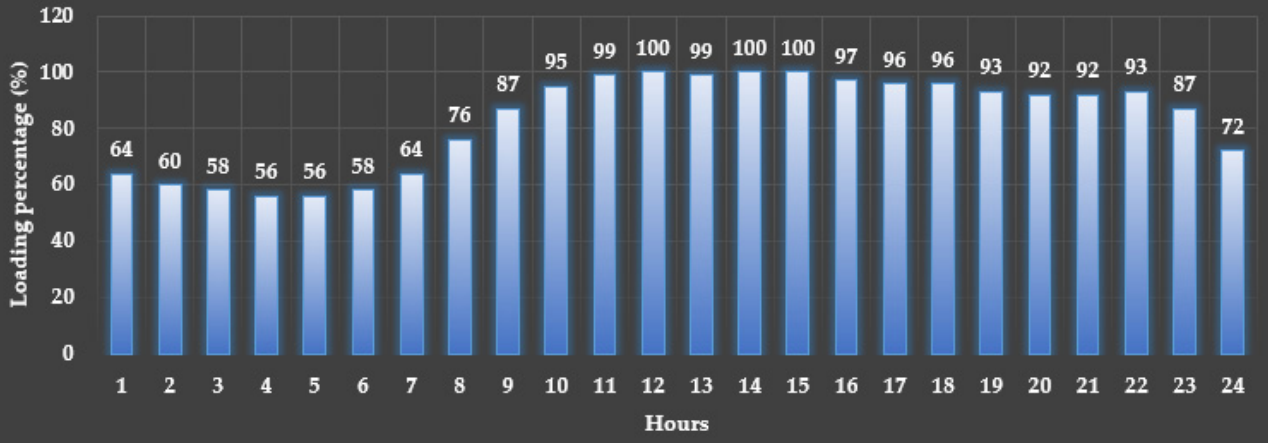
Figure 4. Loading pro fi le per hour as a percent of the nominal condition [35].